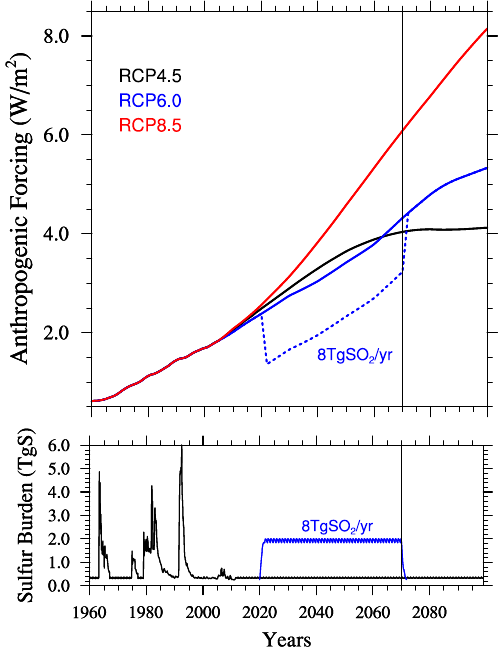
Figure 1. Top panel: total anthropogenic radiative forcing of the CMIP5 model experiments RCP4.5 (black), RCP6.0 (blue), and RCP8.5 (red) (Meinshausen et al., 2011). The dashed line indicates the radiative forcing of the GeoMIP experiment for CCMI, using a prescribed aerosol distribution assuming an emission of 8Tg SO 2 per year. The amount of radiative forcing reduction due to the en- hanced aerosol burden is estimated based on the ECHAM5-HAM model (see text). Bottom panel: sulfur burden in TgS (in the form of H 2 SO 4 ) per year, based in the CCMI prescribed aerosol data set (black) and the new GeoMIP experiment data set (blue), based on 8Tg SO 2 emission per year case.